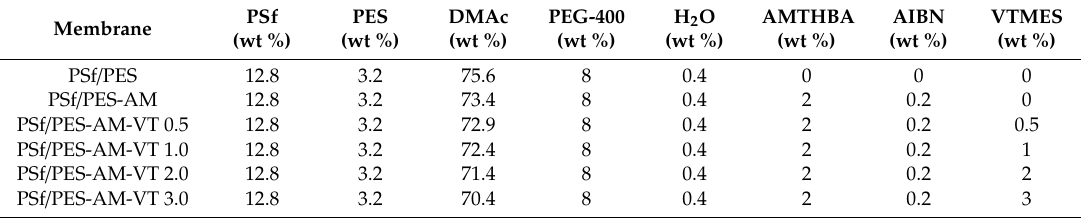
Table 1. Compositions of casting solutions used to prepare the modified